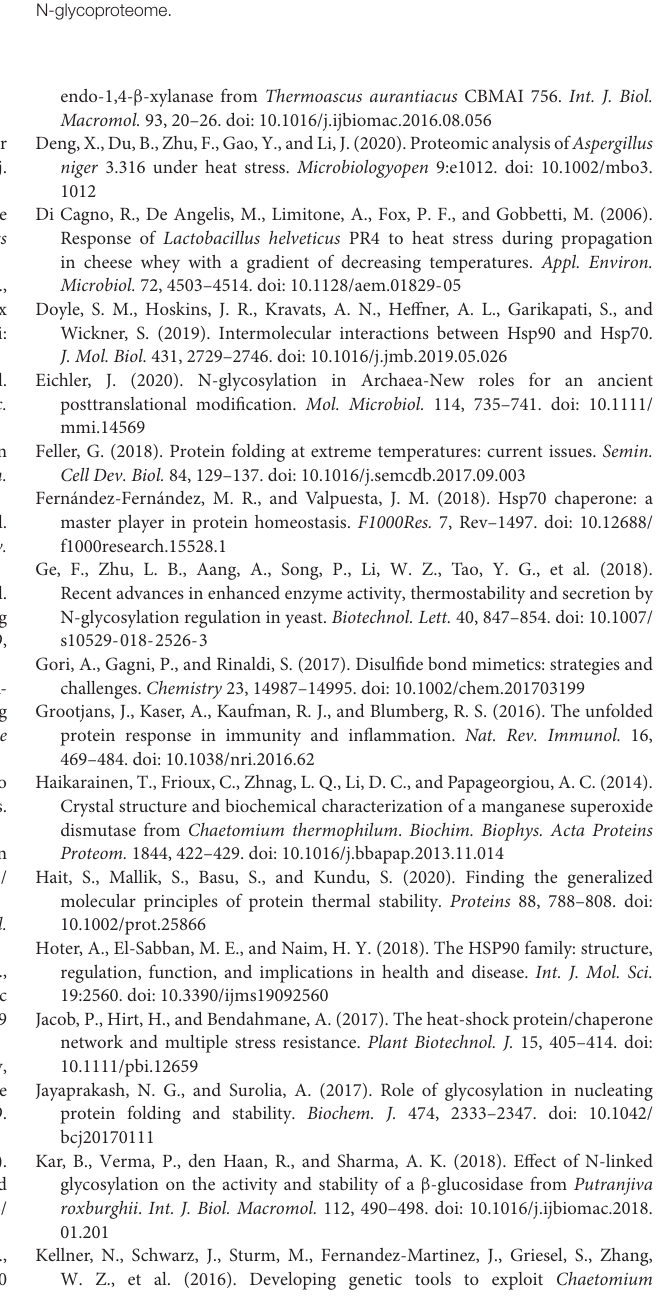
Supplementary Table 5 | Enrichment of gene ontology analysis of differentially expressed proteins. Supplementary Table 6 | KEGG pathway of differently expressed proteins. Supplementary Table 7 | Proteins data of venn diagrams in proteome. Supplementary Table 8 | GO annotation of differentially expressed N-glycoproteins. Supplementary Table 9 | Proteins data of venn diagrams in